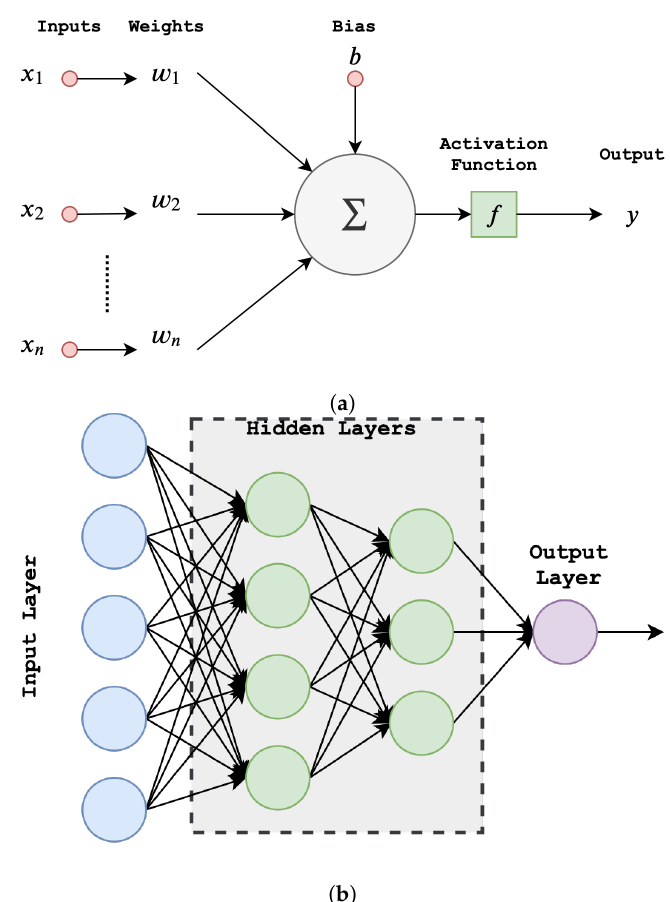
Figure 1. Illustration of an artificial neuron and a simple neural network with 2 hidden layers. In practice, there could be many layers and many neurons per layer. Note that the output of a neuron depends on a non-linear combination of the inputs, provided f ( x ) is a non-linear function. ( a ) Artificial neuron. ( b ) Multilayer